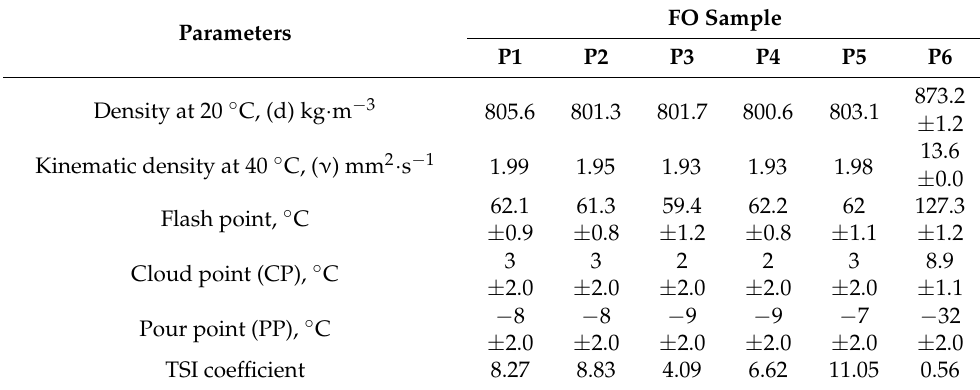
Table 2. The low-temperature properties of the tested oils. Parameters